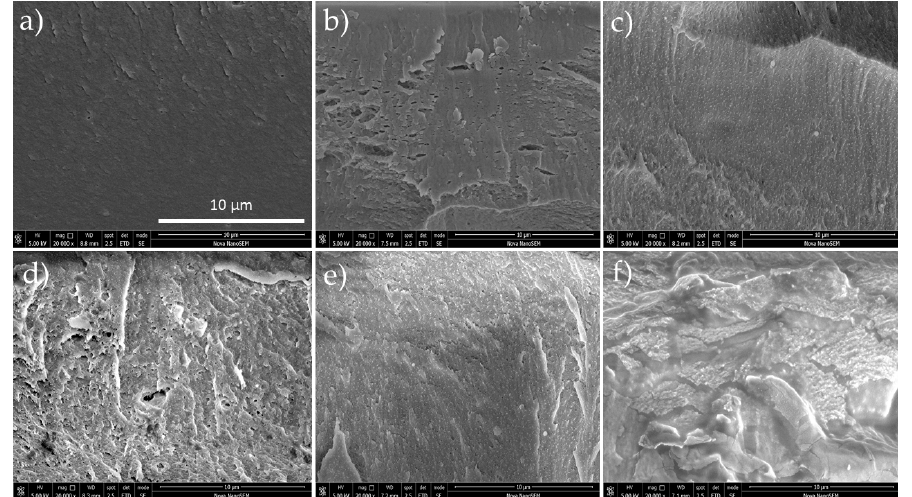
PVA / CHI / FUC / AMP